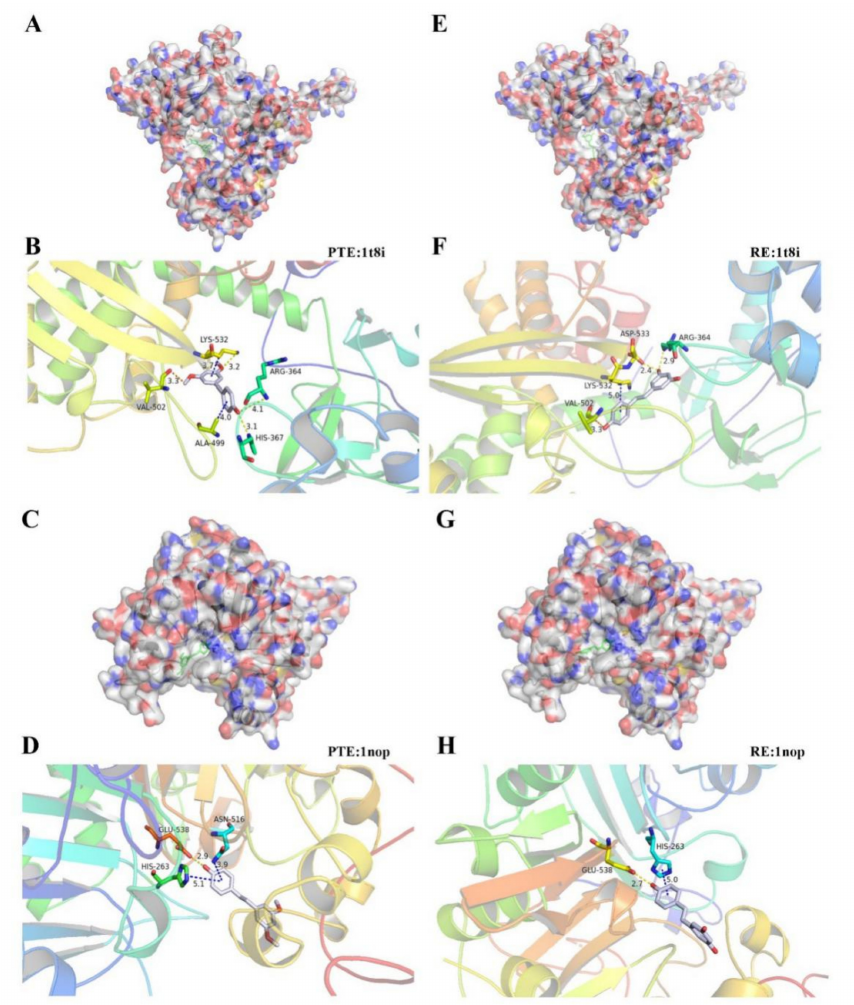
Figure 5. Molecular docking of PTE ( A – D ) and RE ( E – H ) in the active site of Top1 (PDB ID: 1T8I) and Tdp1 (PDB ID:1NOP). PTE and RE could enter the active center pocket of Top1 and Tdp1 and interact with the protein. Hydrogen bonds are indicated with yellow dashed lines, carbon-hydrogen bonds are indicated with orange dashed lines, and pi bonds are indicated with blue dashed lines. The carbons of compounds are colored in gray, nitrogen atoms in blue, and oxygen atoms in